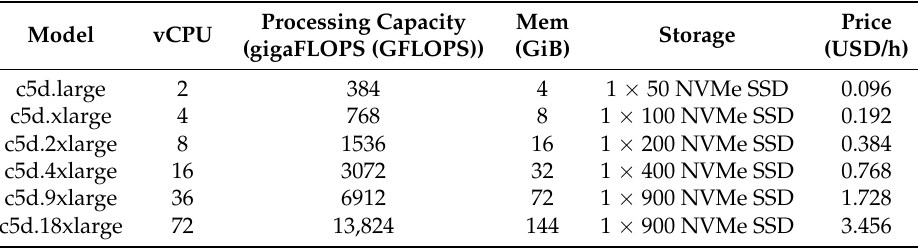
Table 2. Compute optimized C5 VM instances in Amazon